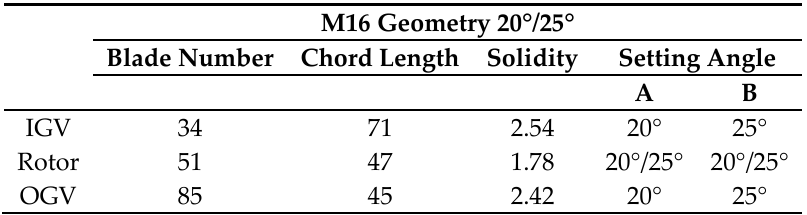
Table 1. geometrical